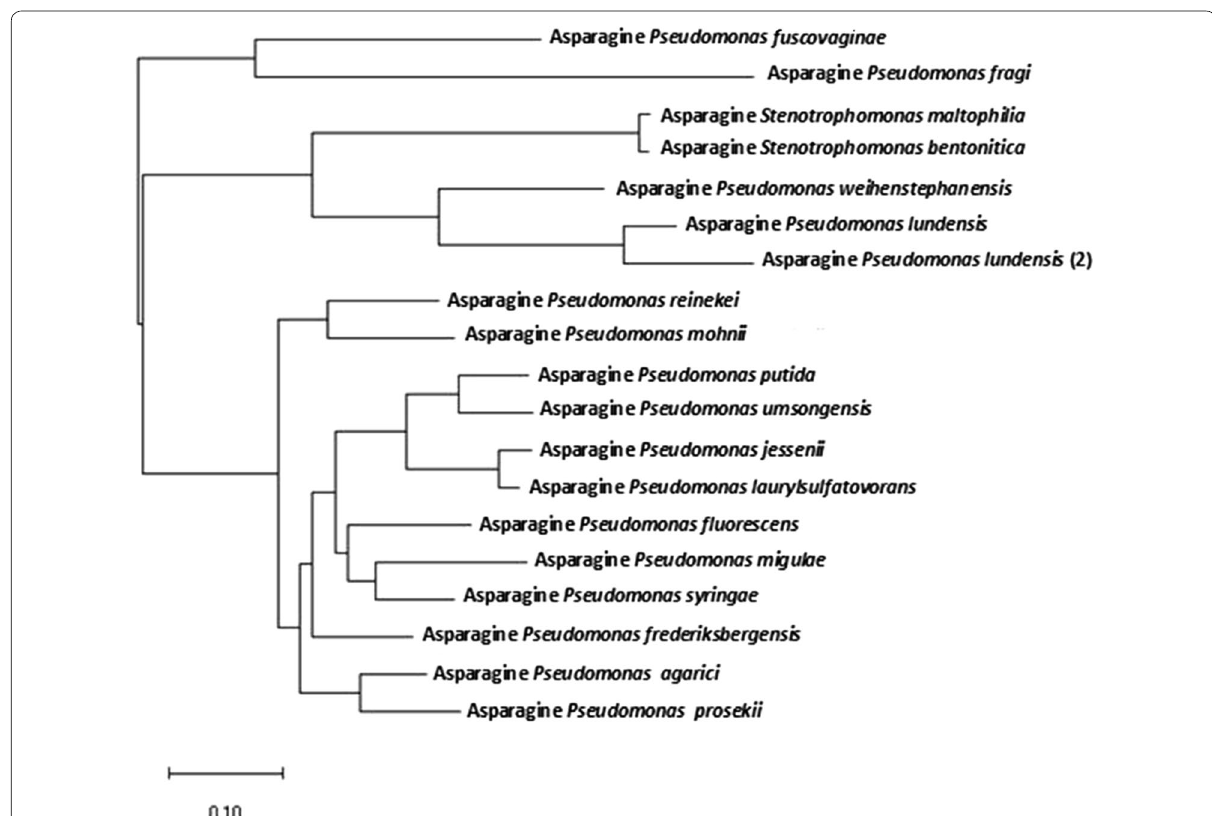
Fig. 1 Phylogenetic analysis of l -asparaginase produced by Stenotrophomonas maltophilia as determined by Maximum Likelihood method. Non redundant amino acid sequences of l -asparaginases retrieved from NCBI databases with similarities more than 56% were aligned against the query sequence ( l -asparaginase of Stenotrophomonas maltophilia ) and used for the tree construction. Additional file 1: Table S1 shows query coverage, E value, percent identity and accession numbers of amino acid sequences of l -asparaginases for the tested bacterial species as revealed by NCBI